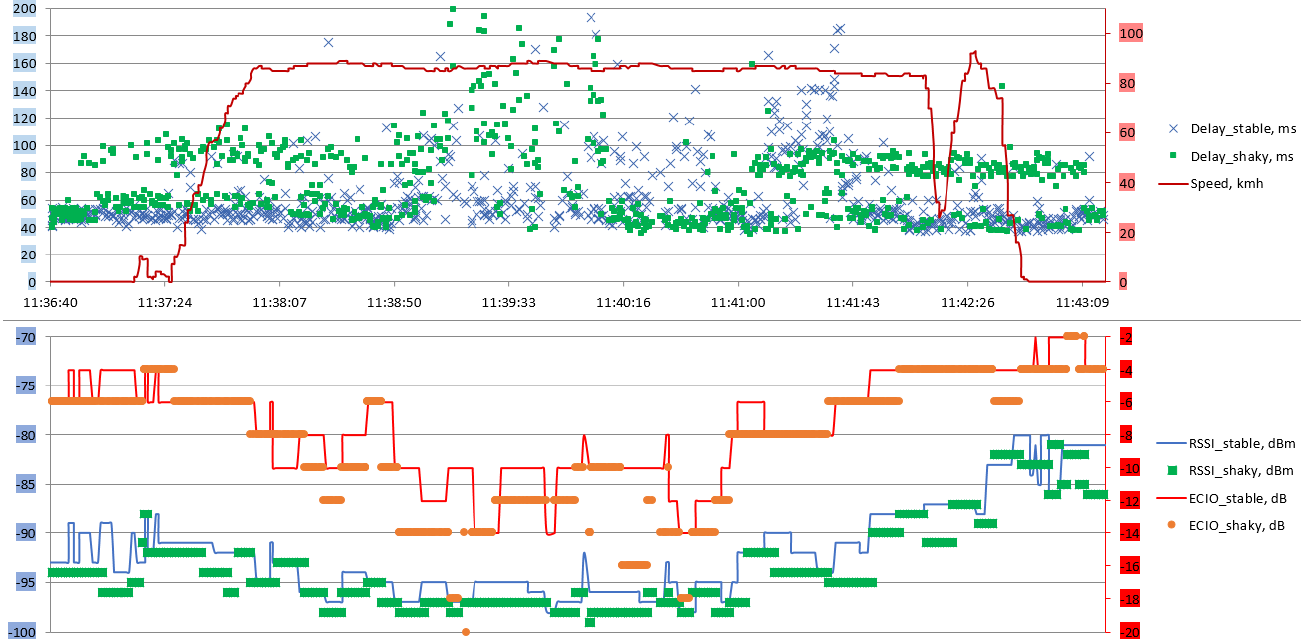
Fig. 7. Network performance for the movable UE with fixed and with jiggled antennas in 3G HSPA+ mode.